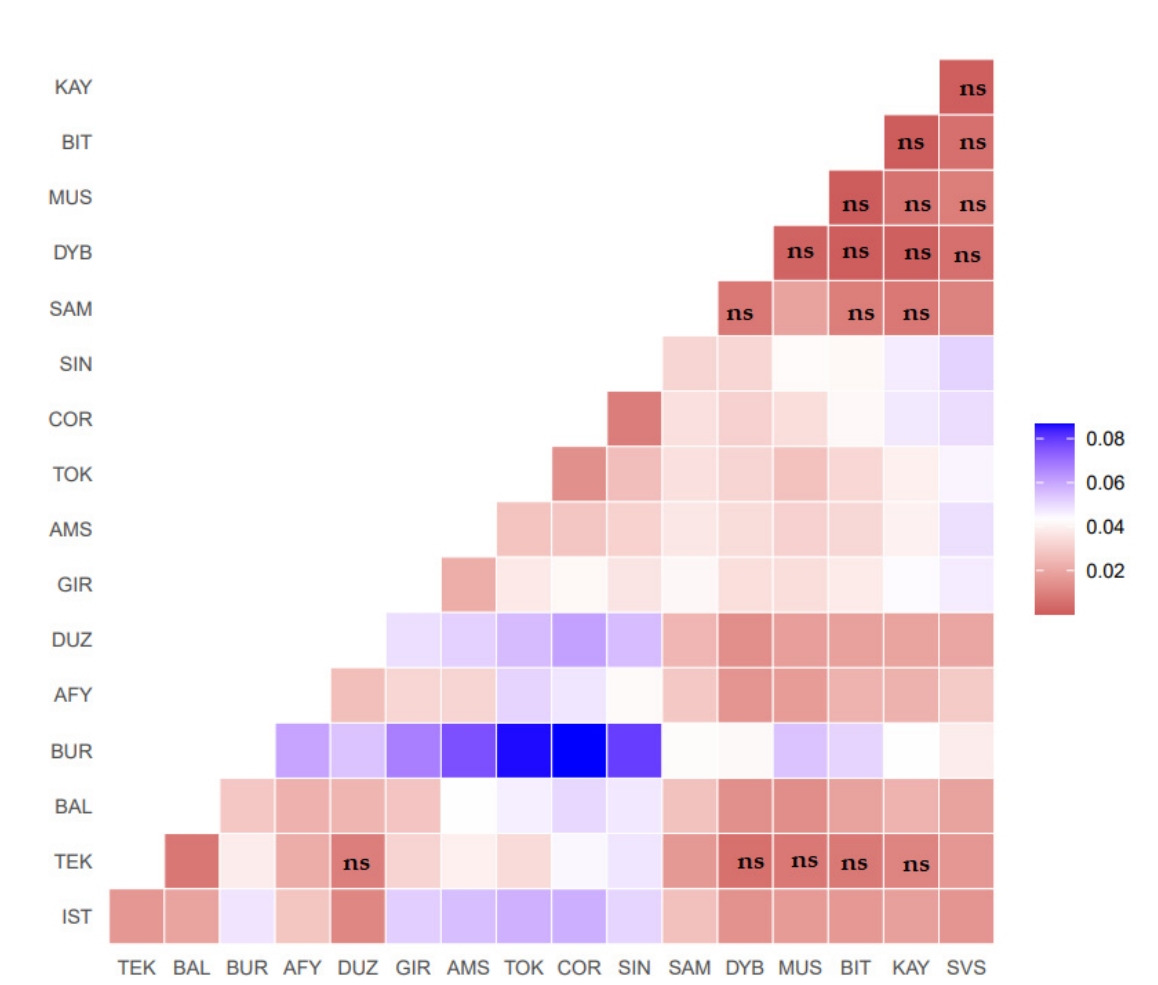
Figure 1. The pairwise F ST distances between the studied 17 Turkish water buffalo populations. Color-codes are identified on the scale at the right side of the figure (ns = not significant, blank significant p < 0.001, pairwise populations F ST values and significant were shown in Supplementary Table S3c). ˙Istanbul/Çatalca-IST; Tekirda˘g/Saray-TEK; Balıkesir-BAL; Bursa-BUR; Düzce-DUZ; Giresun-GIR; Amasya-AMS; Tokat-TOK; Çorum-COR; Sinop-SIN; Samsun-SAM; Afyon-AFY; Kayseri (KAY), Sivas-SVS; Mu¸s-MUS, Bitlis-BIT;